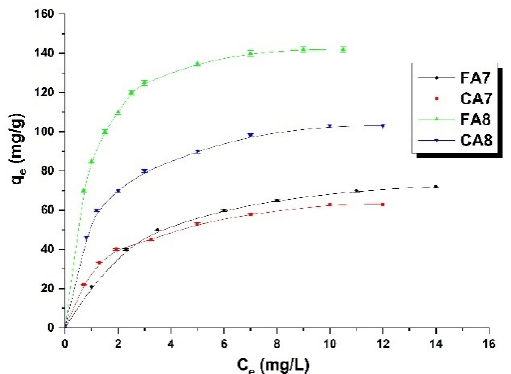
Figure 4. Isotherms of methyl red sodium salt adsorption on biocarbons (biocarbon mass: 25 mg, initial dye solution concentration: 10–80 mg/L, methyl red sodium salt solution volume: 50 mL, temperature: 23 ± 1 °C).